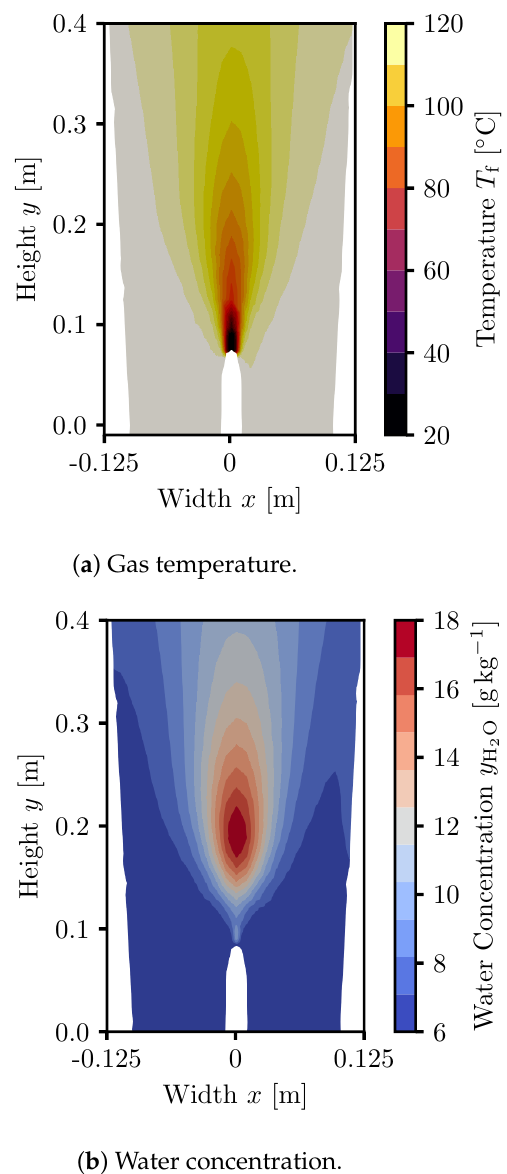
Figure 10. Time-averages over 10 s of simulation time, showing gas temperature and water con- centration in the gas phase in the apparatus midplane ( z = 0). The process conditions were set at a fluidization gas velocity ˙ V air = 130Nm 3 h − 1 and temperature T air,in = 120°C, a spray rate of 1 , an atomization pressure of p ˙ M spray = 10g min − spray = 3.0bar and a spray air temperature of 20